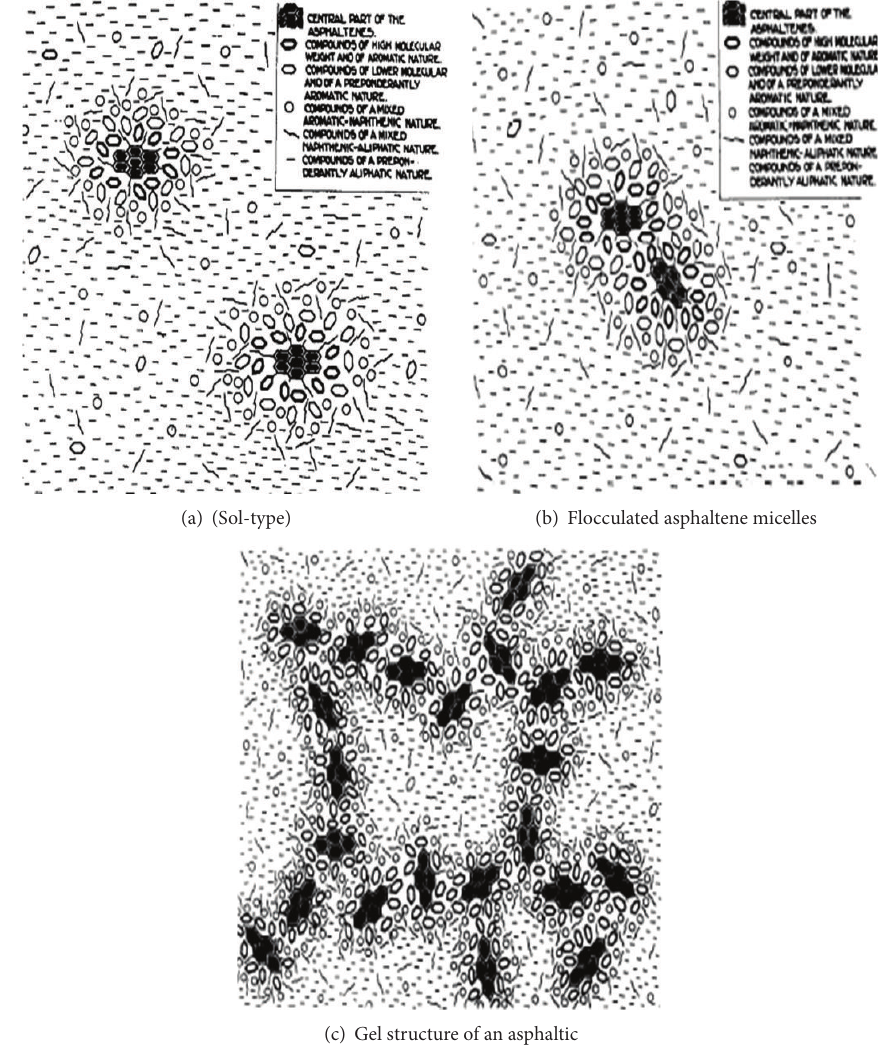
Figure 7: Asphalt colloidal model